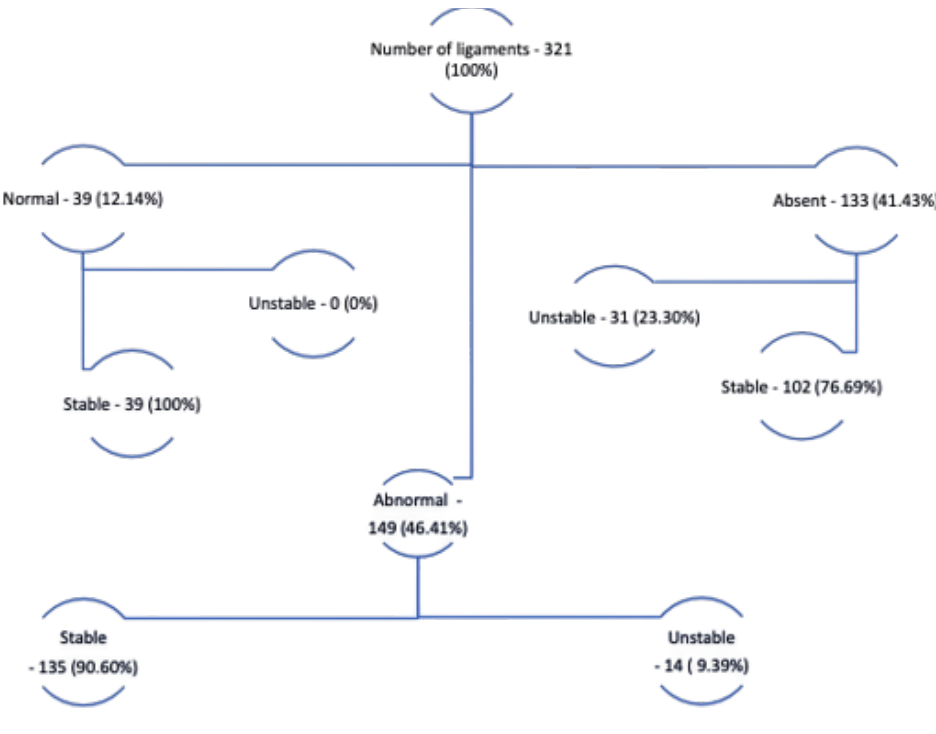
Figure 4. Distribution of normal, abnormal, and absent ATFL and CAI.